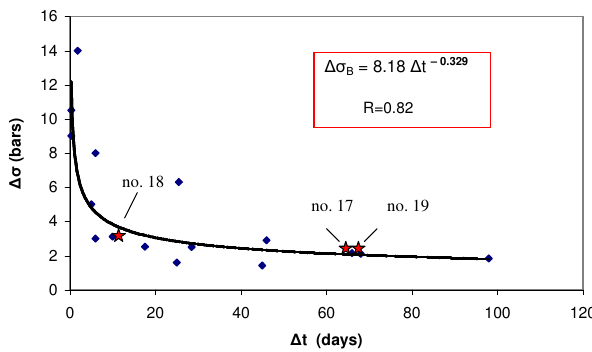
∆σ Β = 8.18 ∆ t – 0.329